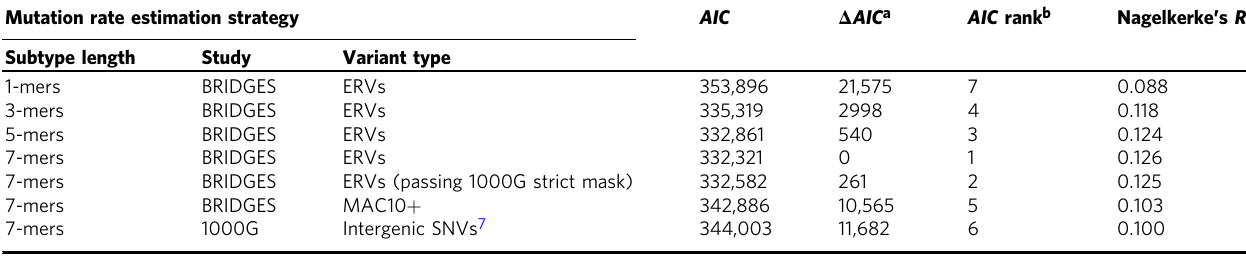
Table 1 Goodness-of- fi t statistics for mutation rate estimates applied to de novo testing data Mutation rate estimation